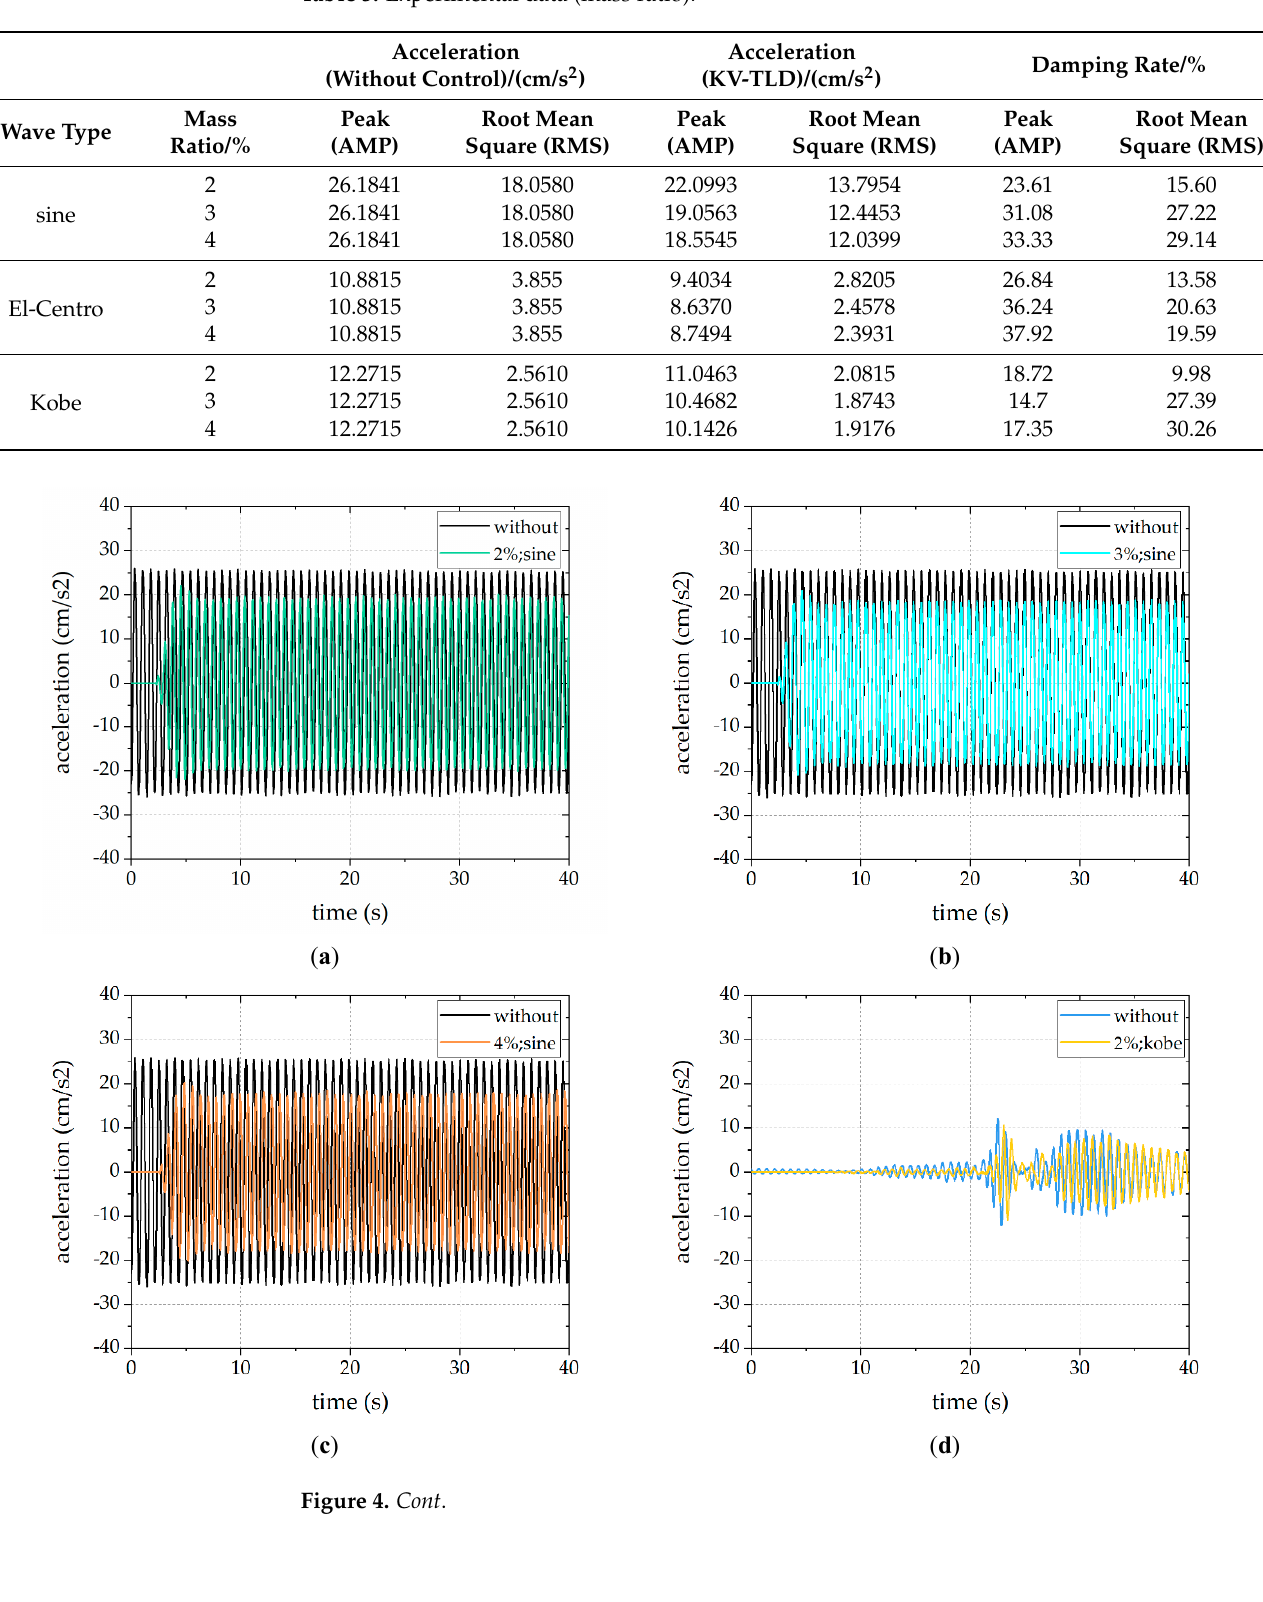
Table 3. Experimental data (mass ratio).